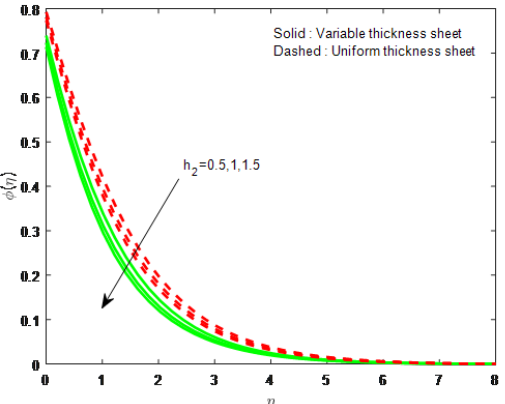
Fig. 18: Influence of h 2 on concentration field